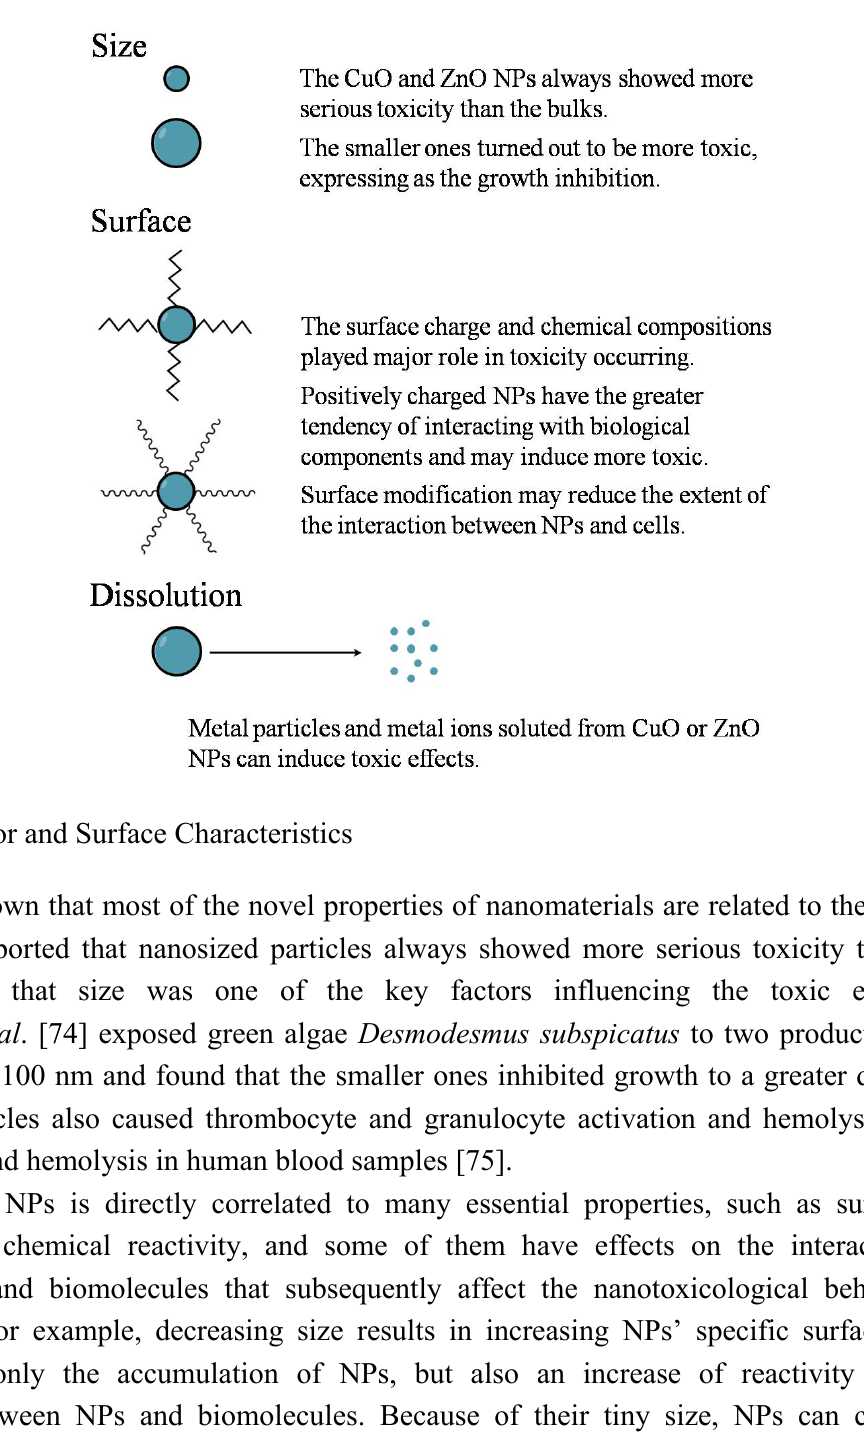
Figure 2. Schematic overview of relevant NPs’ characteristics that can be controlled to influence toxicity: size, surface modification, and solubility. Please see the main text for further details and